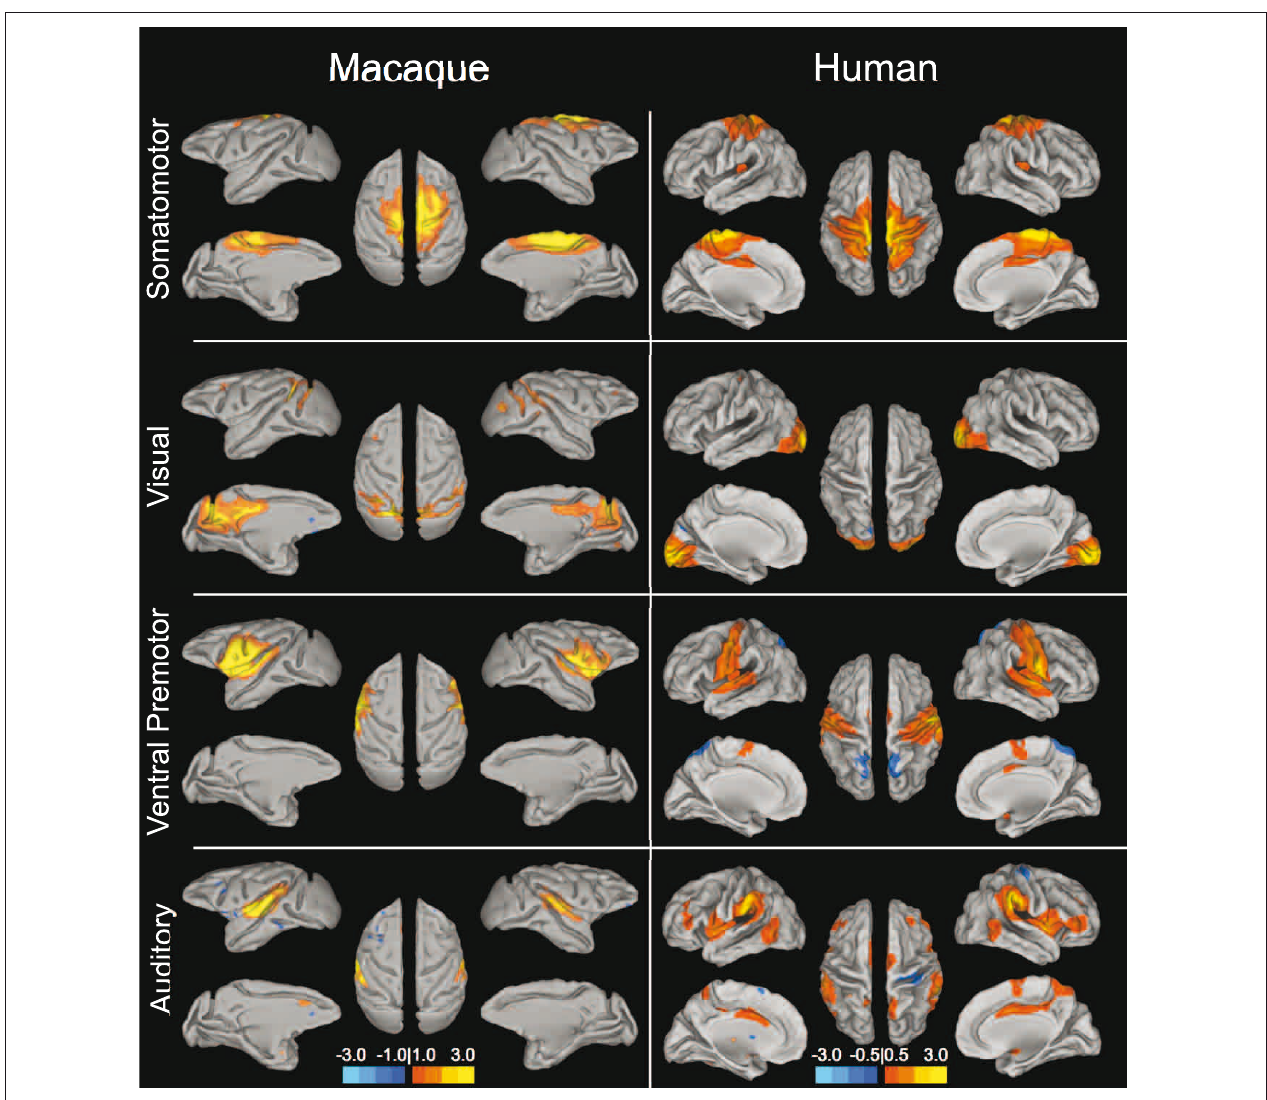
FIGURE 1 | Sensory and motor resting-state networks of the macaque (left column) and human (right column) showing connectivity between bilateral homologs. Putative functional roles of the networks are indicated